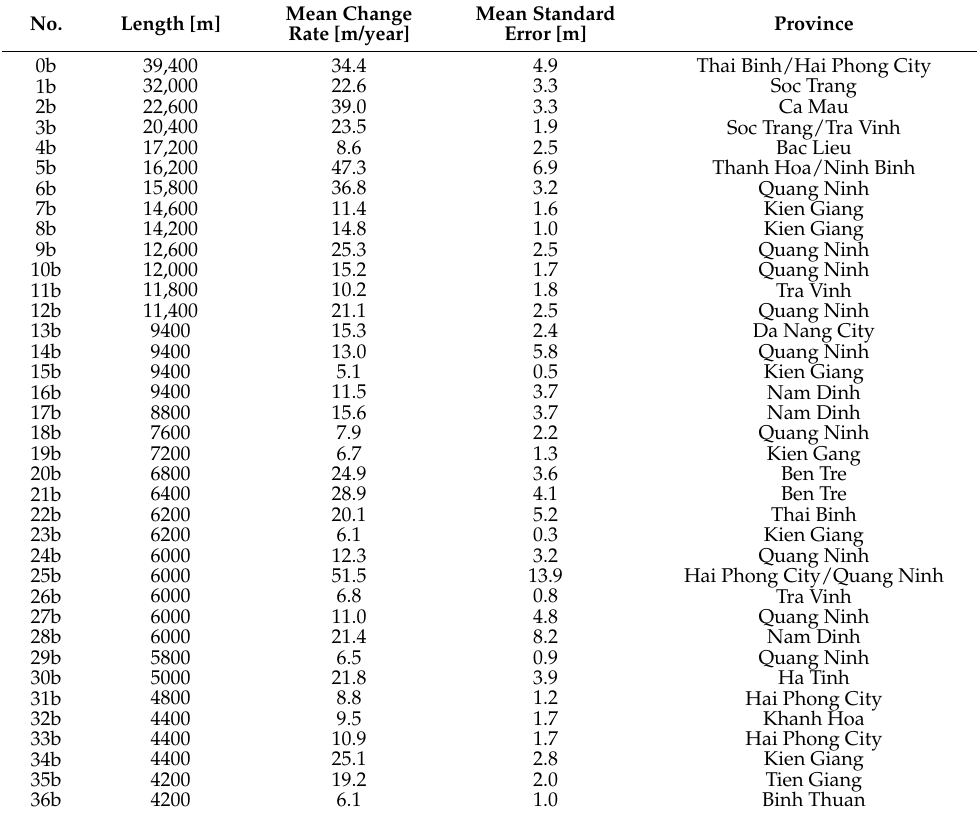
Table 4. Accretion hotspots in Vietnam from 1986 to 2021.